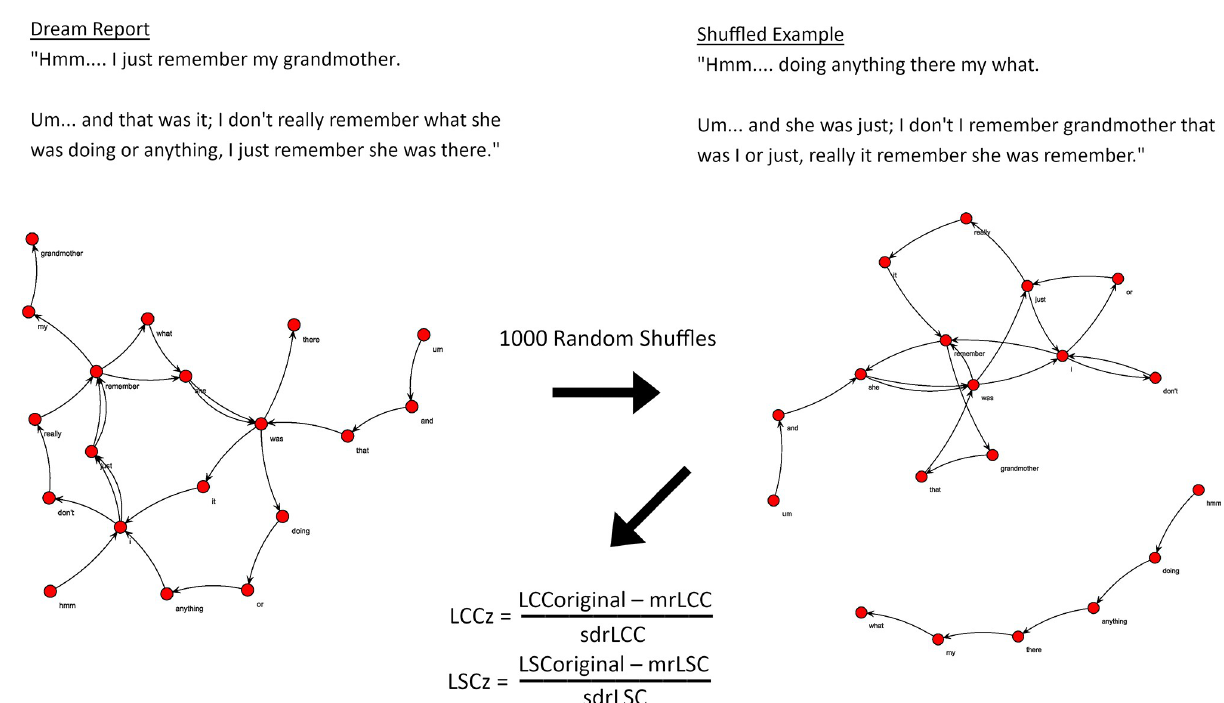
Fig 3. Illustration of random shuffling. Word order from the dream report is randomly shuffled 1000 times. The abbreviations “mr” and “sdr” denote the respective mean (mrLCC, mrLSC) and standard deviation (sdrLCC, sdrLSC) scores calculated from this distribution of 1000 shuffled reports. An overall measure of random-like quality is then estimated using the average scores of LCC and LSC based upon this iteration.